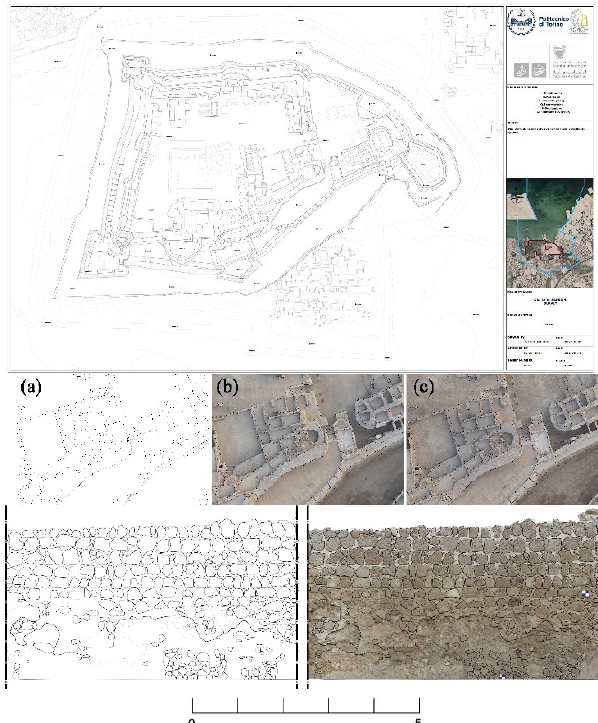
Figure 17. 3D elevation plan with orthoimage of the area derived from the integrated metric survey of Qal’at al-Bahrain and its surrounding. Source: authors and